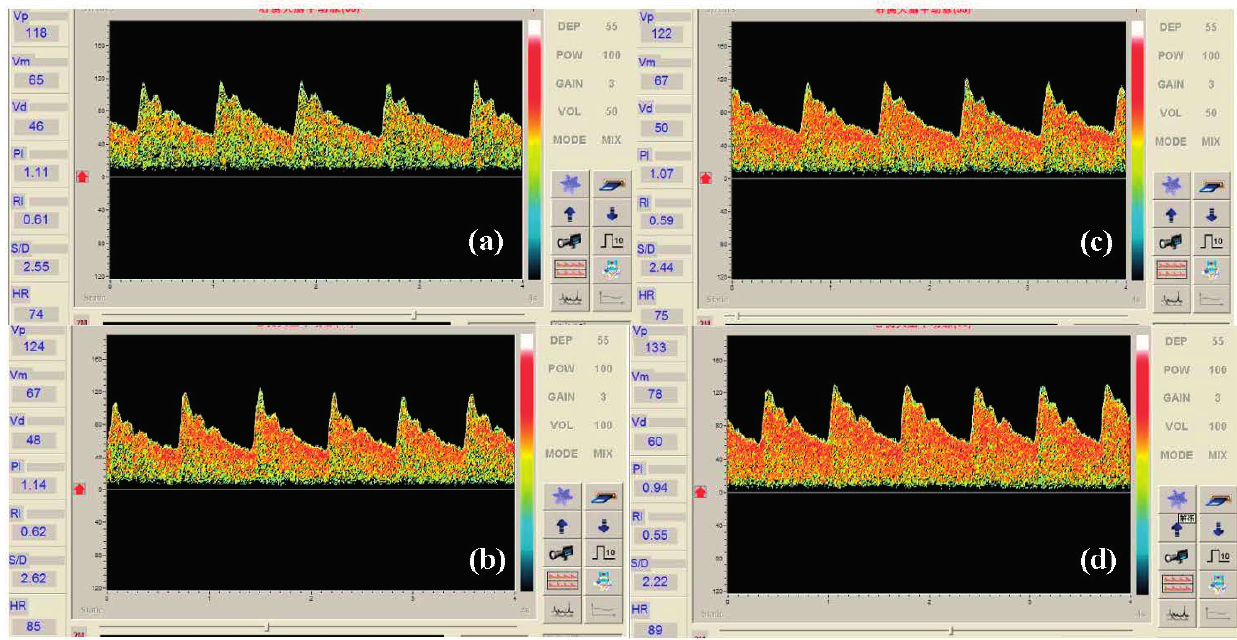
Figure 6. Doppler sonographic measurement of MCA at the transmission powers